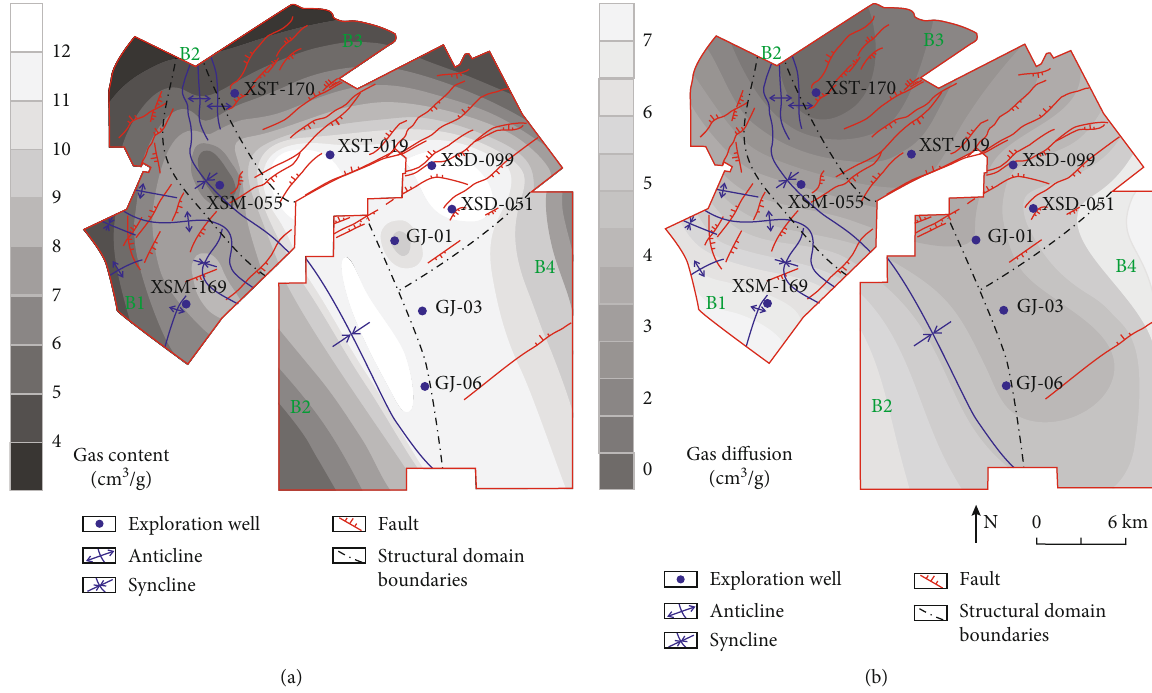
Figure 16: Distribution characteristics of current gas content (a) and gas di ff usion during substage VI